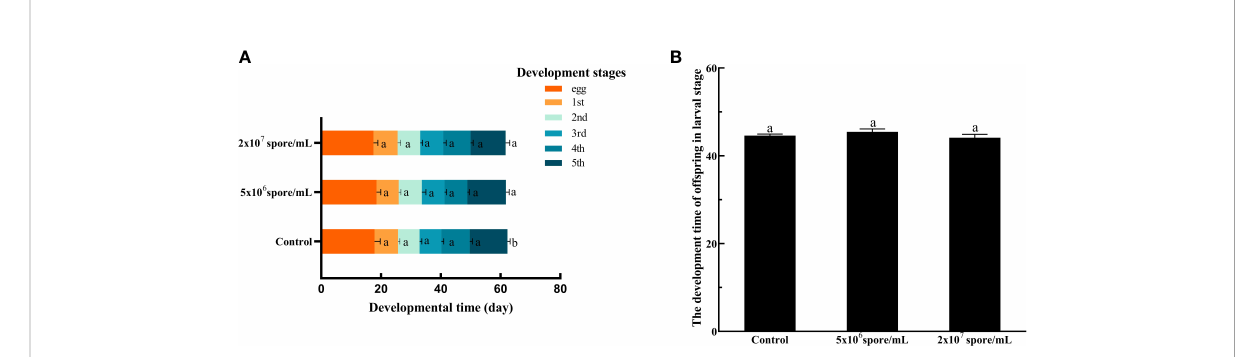
FIGURE 6 Development time of nymphs after L. migratoria manilensis infected with P. locustae . (A) Development time of each instar: egg, egg stage;1st, 1st instar nymph;2nd, 2nd instar nymph; 3rd, 3rd instar nymph; 4th, 4th instar nymph; 5th, 5th instar nymph. (B) Total time for offspring to develop from egg to adult. Each value is presented as mean ± SD, and different letters indicate signi fi cant differences among treatments (one- way ANOVA followed by Tukey ’ s multiple comparisons test, P <